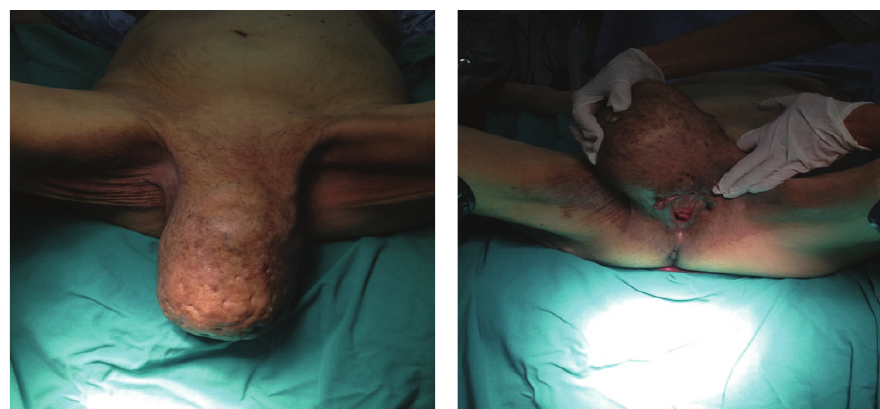
Figure 1: Angiofibroma arising from the right labia major.